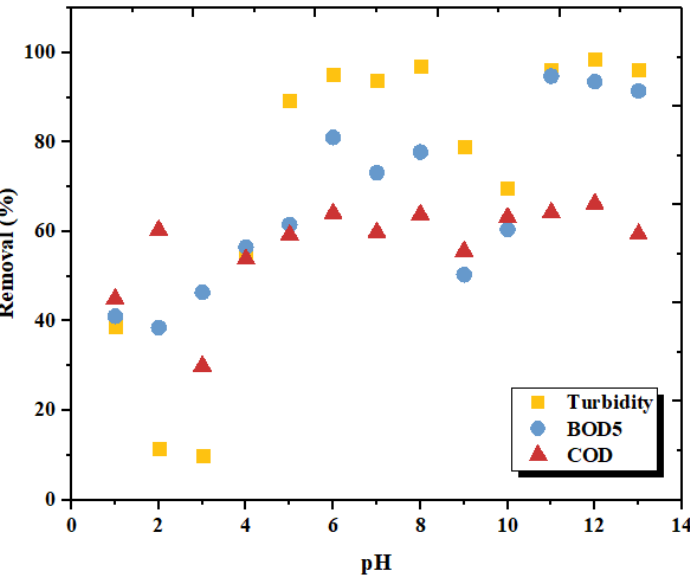
Figure 15. Effect of pH on turbidity, BOD 5 and COD removal efficiency.